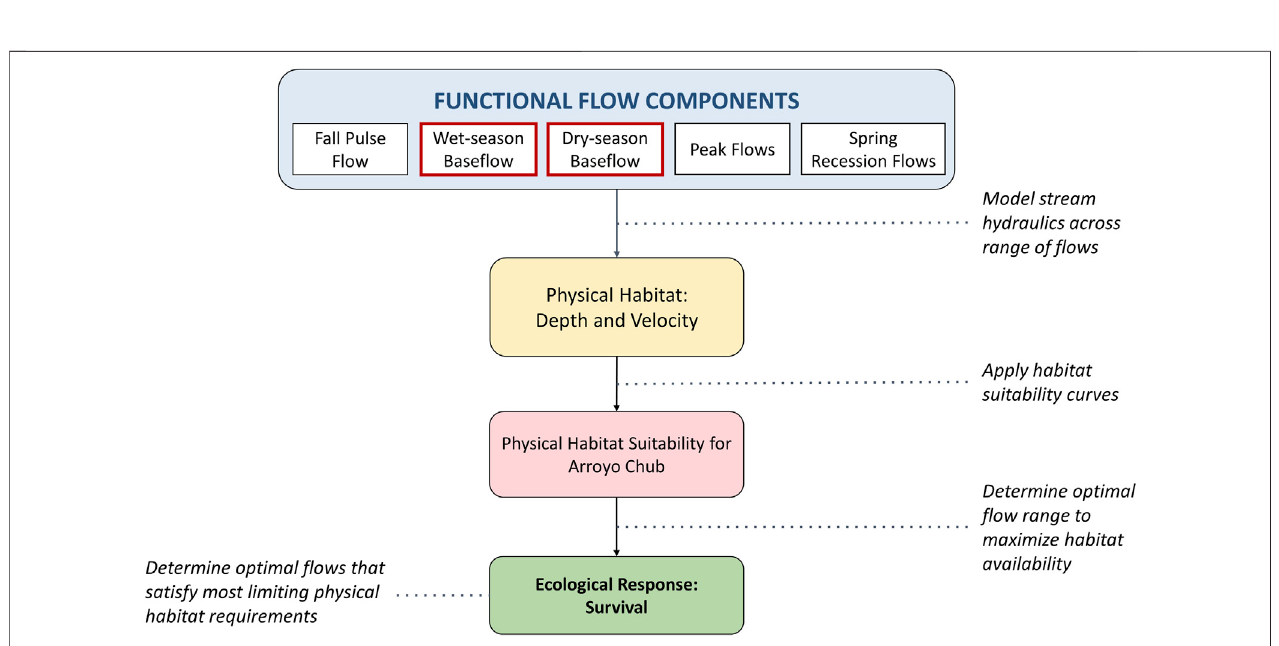
FIGURE 5 | Conceptual model for re fi ning ecological fl ow needs for dry-season and wet-season base fl ow components based on arroyo chub.